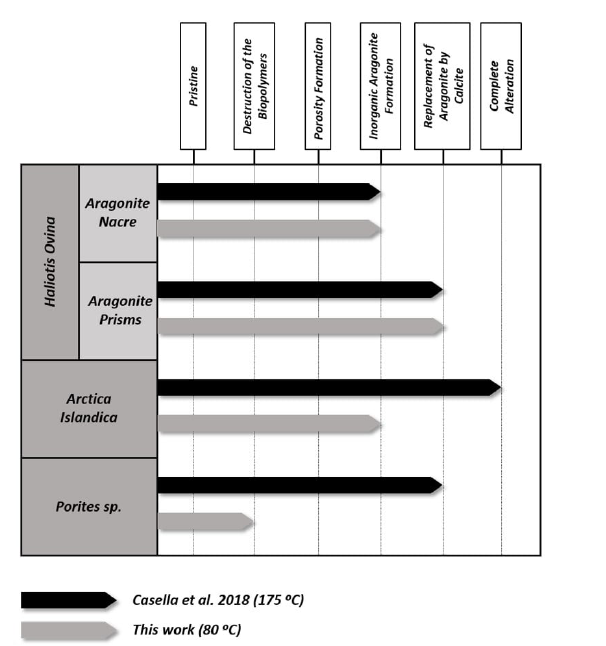
Figure 10. Main intermediate stages of alteration reached by the different aragonitic microstructures from this work when hydrother- mally altered at 80 ◦ C (this work) and 175 ◦ C (Casella et al., 2018). In general, alteration at higher temperatures alters the microstruc- tures more, so they reach further alteration stages. In contrast, when the temperature is lower, the alteration is milder and the aragonitic microstructures reach previous alteration